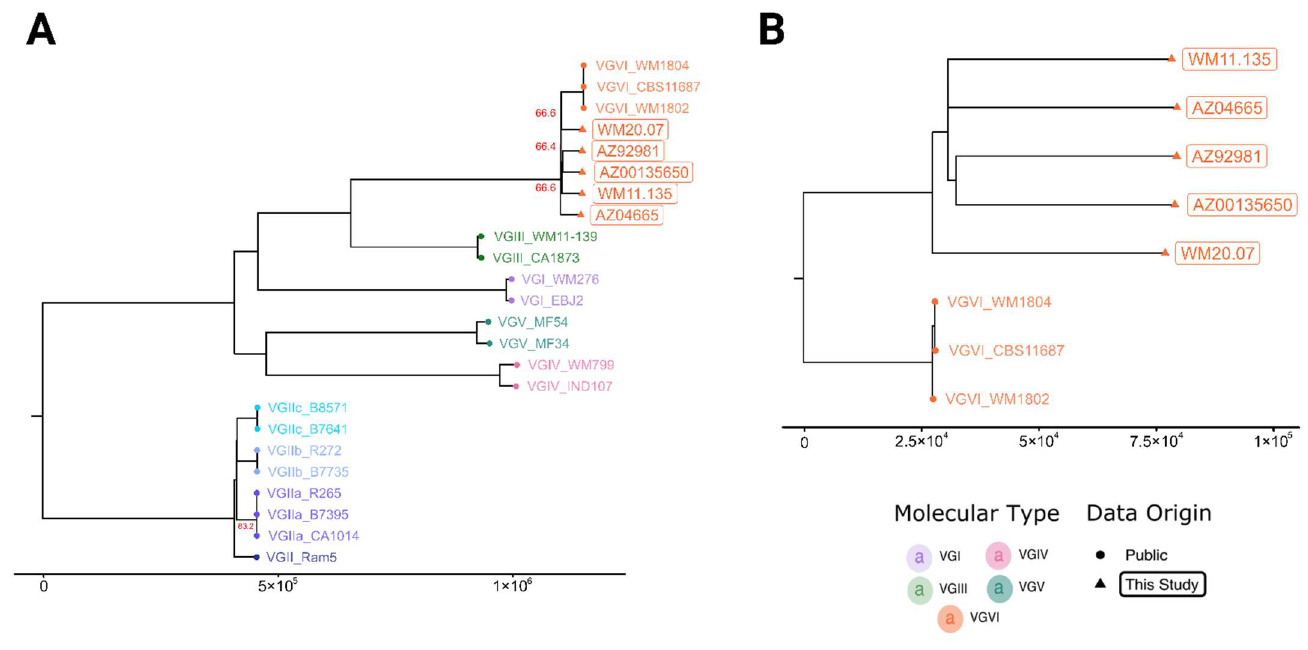
Figure 1. Maximum parsimony phylogenies based on high confidence SNPs showing boxes around the isolates sequenced in this study. ( A ) This analysis of 24 genomes includes two to eight publicly available genomes from each of the major C. gattii molecular types. The tree covers 87.40% of the reference and comprises 1,733,389 polymorphic loci, with a consistency index of 0.88 and a retention index of 0.97. ( B ) The VGVI-only phylogeny includes all eight available genomes for this molecular type and comprises 1,123,371 polymorphic loci covering 91.88% of the reference genome. This phylogeny has a consistency index of 0.78 and a retention index of 0.73. The reference for both trees was AZ04665 draft assembly (17.5 Mbp N50: 185.1 Kbp). All branch bootstrap values equal